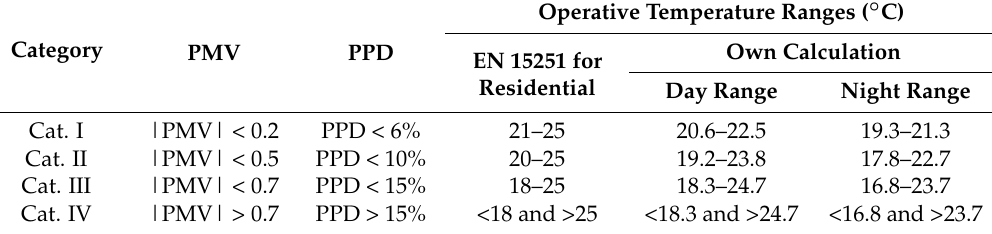
Table 2. Operative temperature ranges for the different categories. For the calculations, the following assumptions are taken: 1.2 met, 1 clo, 0.1 m/s for the day range and 0.8 met, 2.5 clo, 0.1 m/s for the night